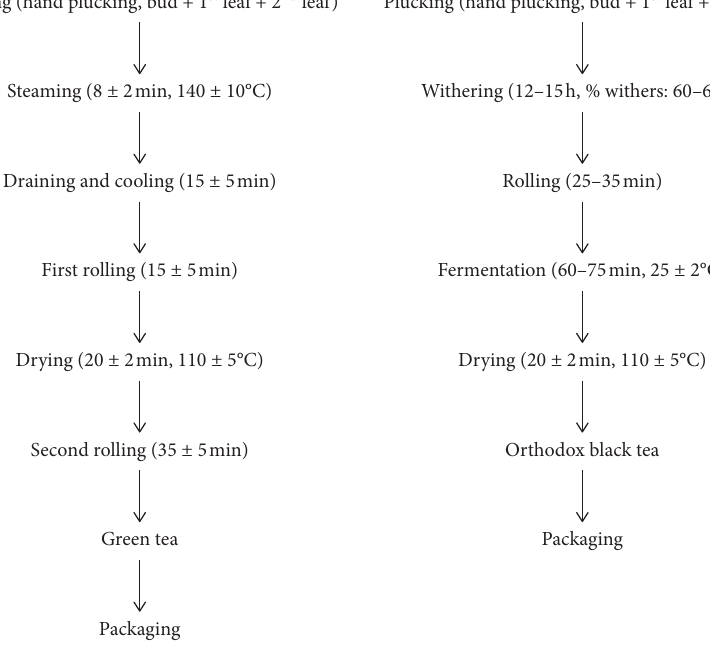
Figure 1: Flow chart illustrating the processes in preparation of (a) green tea and (b) orthodox black